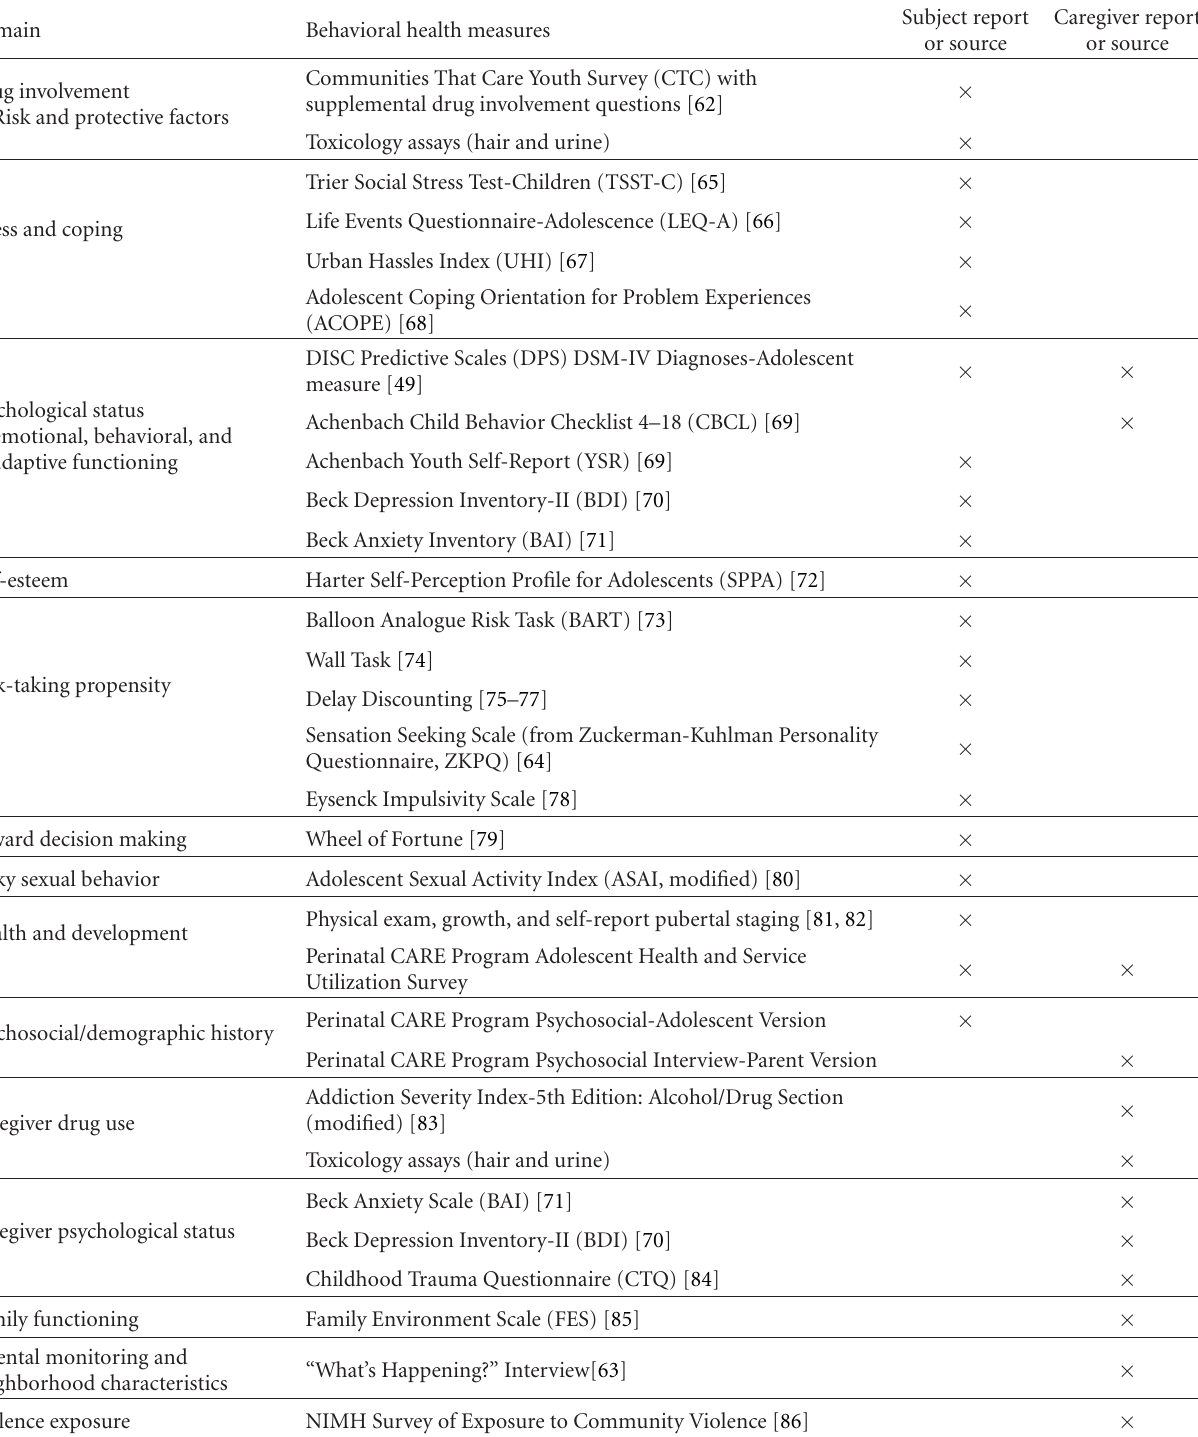
Table 4: Behavioral health assessments of the adolescents and caregivers at the 16/17-year